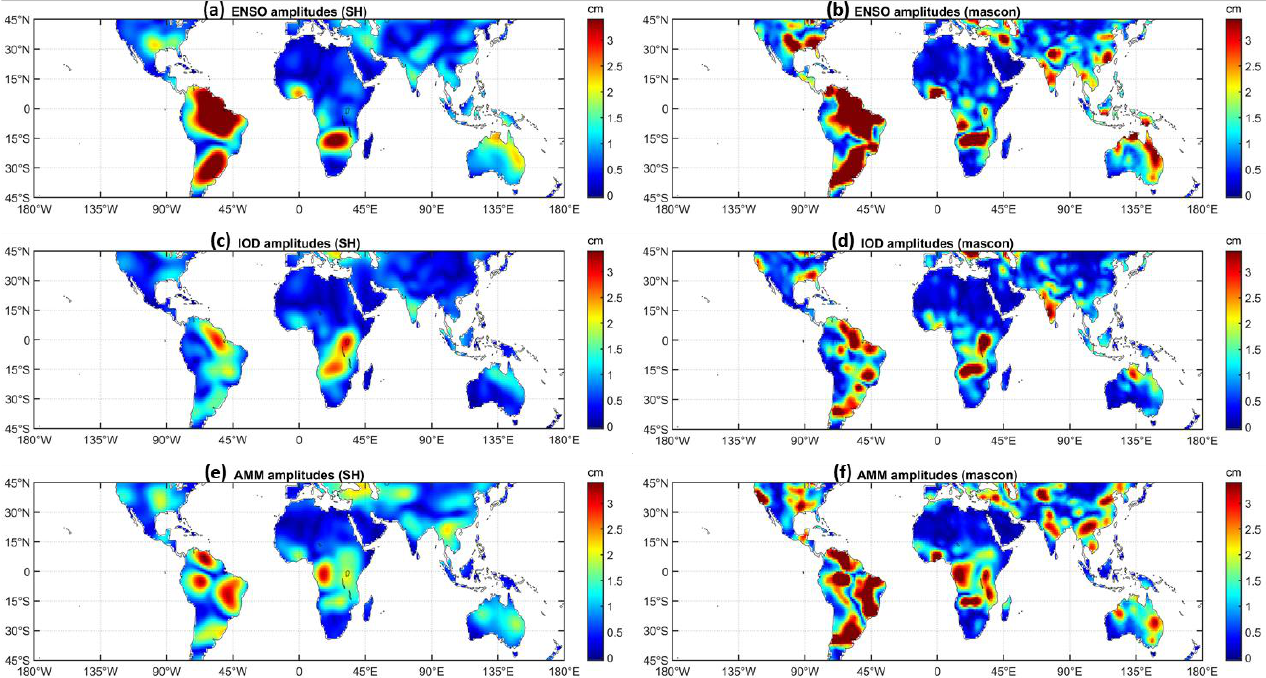
Figure 2. ENSO, IOD, and AMM amplitudes from GRACE spherical harmonics (SH) and mascon solutions. ( a , b ) show ENSO amplitudes from GRACE SH and mascon solutions computed with Equation (3); ( c , d ) show IOD amplitudes from GRACE SH and mascon solutions computed with Equation (4); ( e , f ) show AMM amplitudes from GRACE SH and mascon solutions computed with Equation (5).